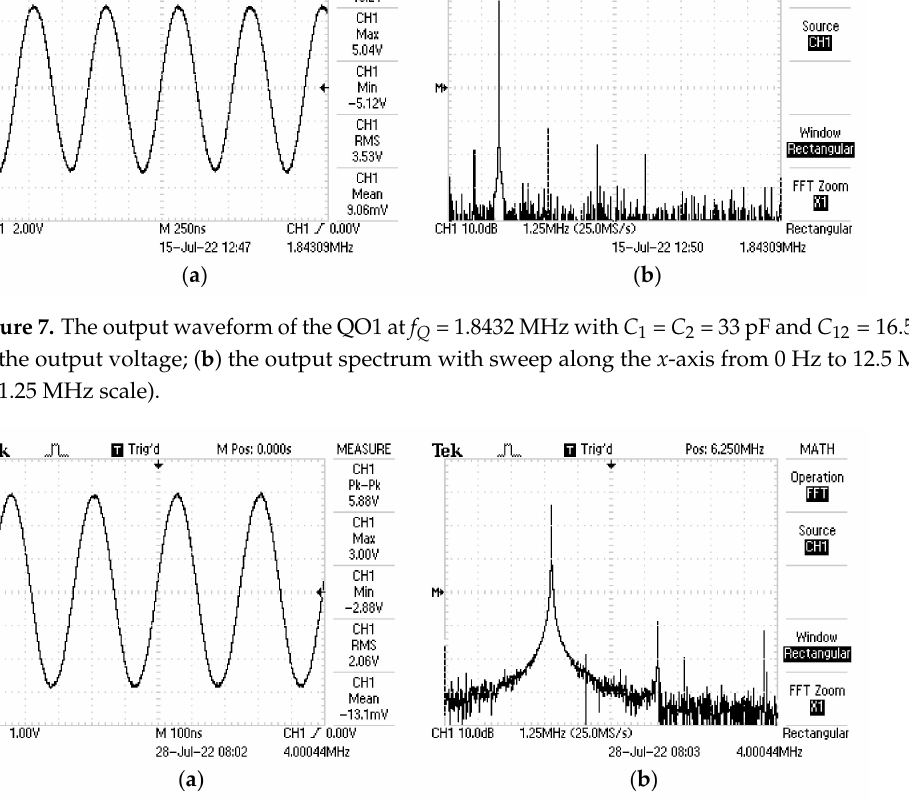
Figure 8. The output waveform of the QO1 at f Q = 4.0000 MHz with C 1 = C 2 = 33 pF and C 12 = 16.5 pF: ( a ) the output voltage; ( b ) the output spectrum with sweep along the x -axis from 0 Hz to 12.5 MHz (at 1.25 MHz